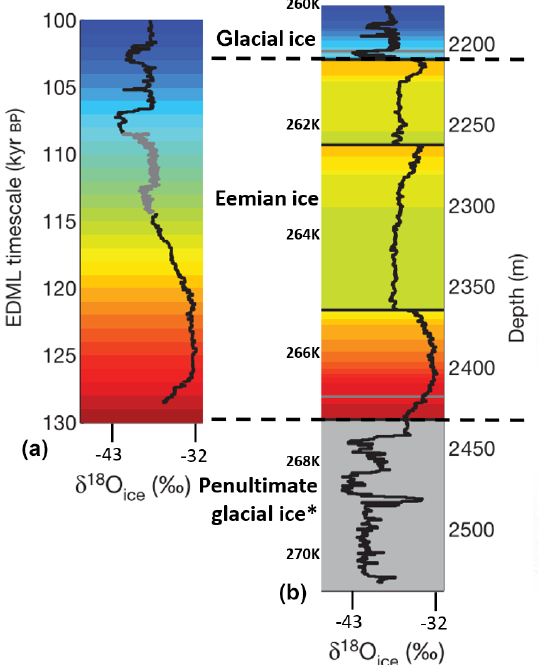
Figure 1. (a) The reconstructed water stable isotope ( δ 18 O ice ) record from NEEM on the EDML1 timescale. The grey curve be- tween 114 and 108kyr BP is NGRIP data. The background has been color-coded based on age. (b) The NEEM stable isotope ( δ 18 O ice ) record on the original depth scale. No dating was attempted below 2432.2m depth. The two dotted lines separate the Glacial, Eemian and what is likely the Penultimate Glacial ice (indicated by *). The in situ temperature at several depths in the NEEM ice core is indi- cated. This figure is based on data from NEEM community mem- bers